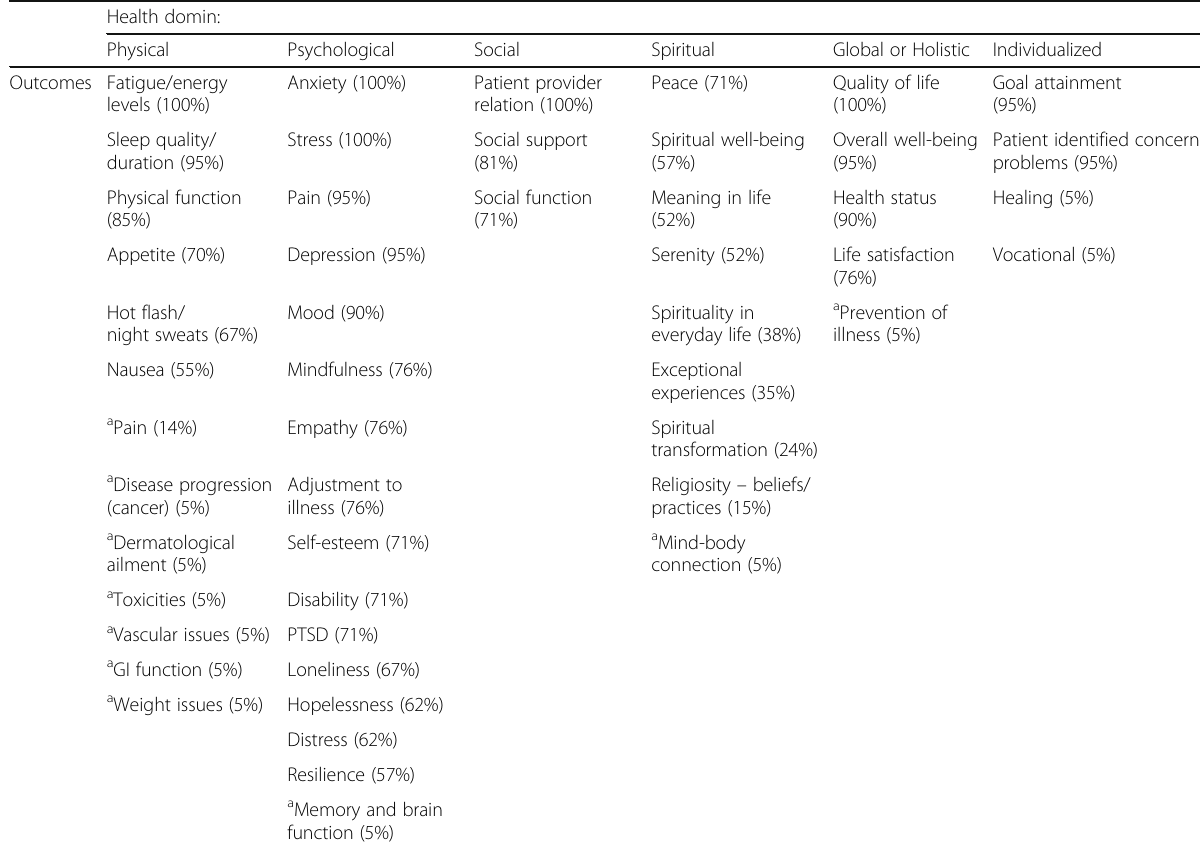
Table 3 Outcomes within each health domain identified as relevant and/or important across the study sites Health